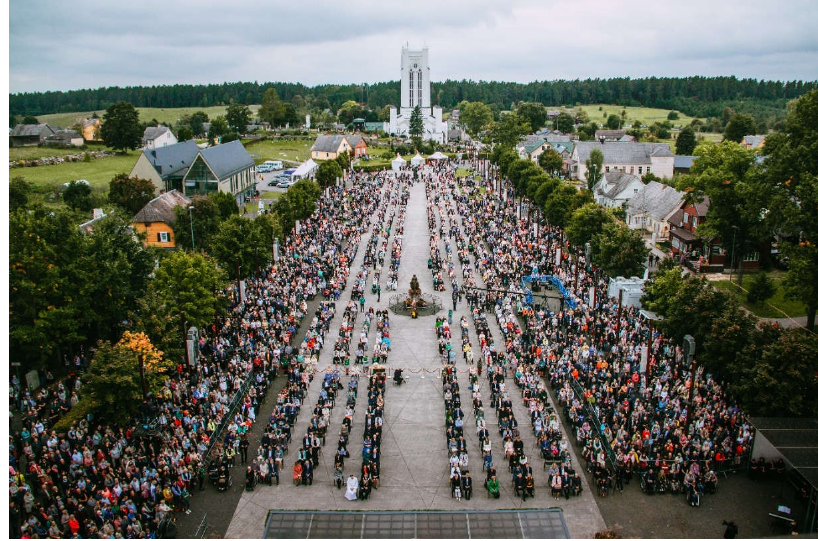
Land 2022 , 11 , x FOR PEER REVIEW Figure 4. Main square of Šiluva during the Holy Mass. Photo by Agnietė Čisler. Figure 4. Main square of Šiluva during the Holy Mass. Photo by Agniet˙e ˇ Cisler.